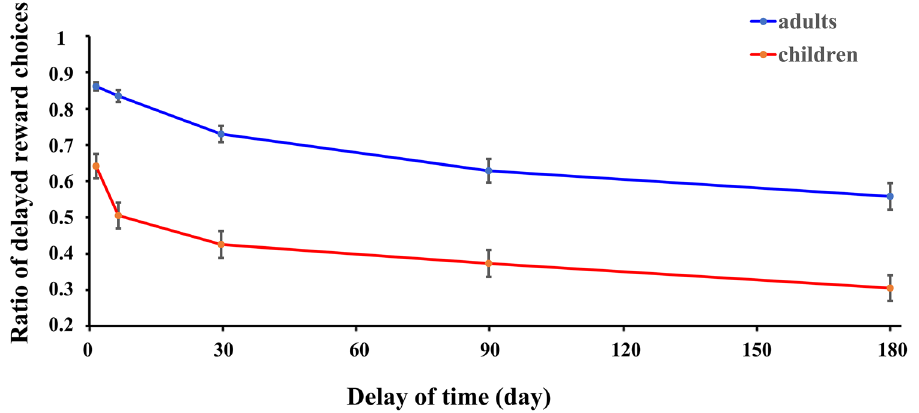
Figure 1. A comparison between children and adults on the ratio of delayed reward choices for various time delays. The picture was created by Microsoft Excel 2016 MSO (16.0.13628.20234) 64 bits (https:// www. micro soft. com/ zh- cn/ micro soft- 365/ excel) and Microsoft PowerPoint 2016 MSO (16.0.13628.20234) 64 bits (https:// www. micro soft. com/ zh- cn/ micro soft- 365/ power point).